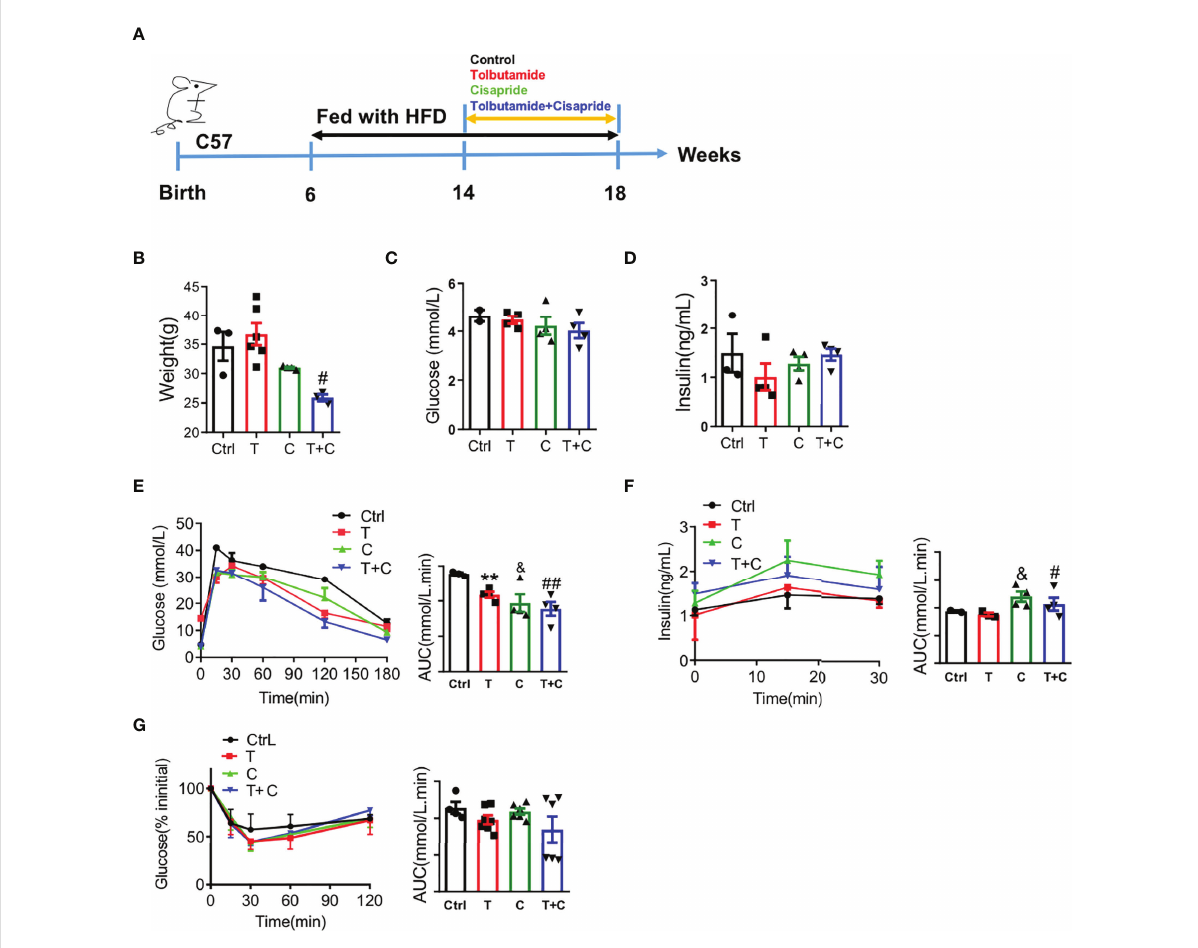
FIGURE 3 Long-term administration of cisapride regulated glucose metabolism in wild-type mice fed a high-fat diet (A) Wild-type (WT) mice were fed a high-fat diet (HFD) for 8 weeks before a 4-week daily administration of different drugs. Mice were divided into four groups: control (physiological saline, Ctrl), tolbutamide (T), cisapride (C) and tolbutamide combined with cisapride (T+C). (B) Body weight, (C) fasting blood glucose and (D) fasting serum insulin were measured. (E) Intraperitoneal glucose tolerance tests (IPGTTs) were performed. (F) Intraperitoneal insulin release tests (IPIRT) were performed. (G) Intraperitoneal insulin tolerance tests (IPITTs) were performed. n=5 for each group (B – G) & P < 0.05, # P < 0.05, ## P < 0.005 vs. Ctrl, ### P < 0.005 vs. Ctrl. Statistical comparisons were calculated using the Mann – Whitney U test (A – F)